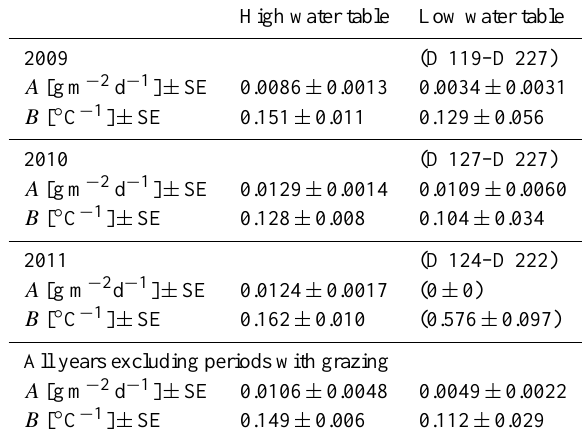
Table 3. Results from the curve fitting for the CH 4 flux versus soil temperature plots shown in Fig. 7, using Eq.